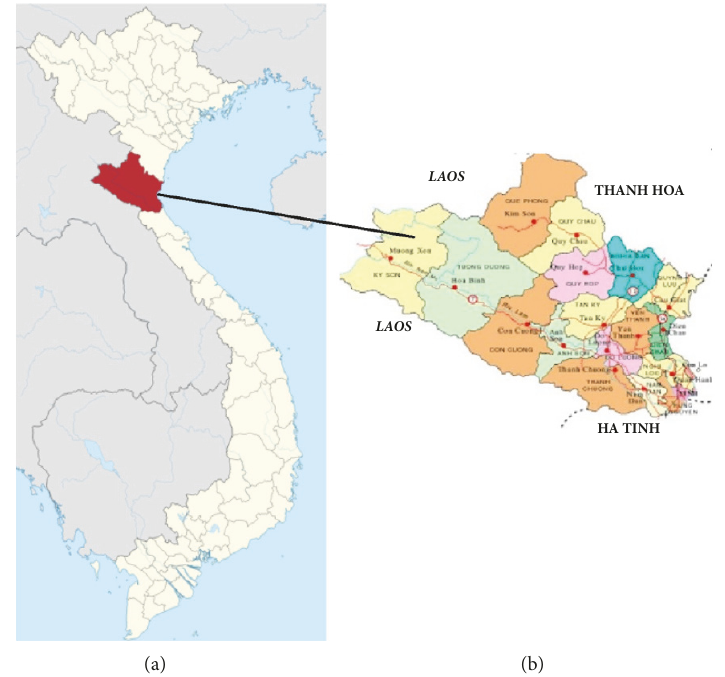
Figure 1: Map of Vietnam (a). Nghe An province, central Vietnam